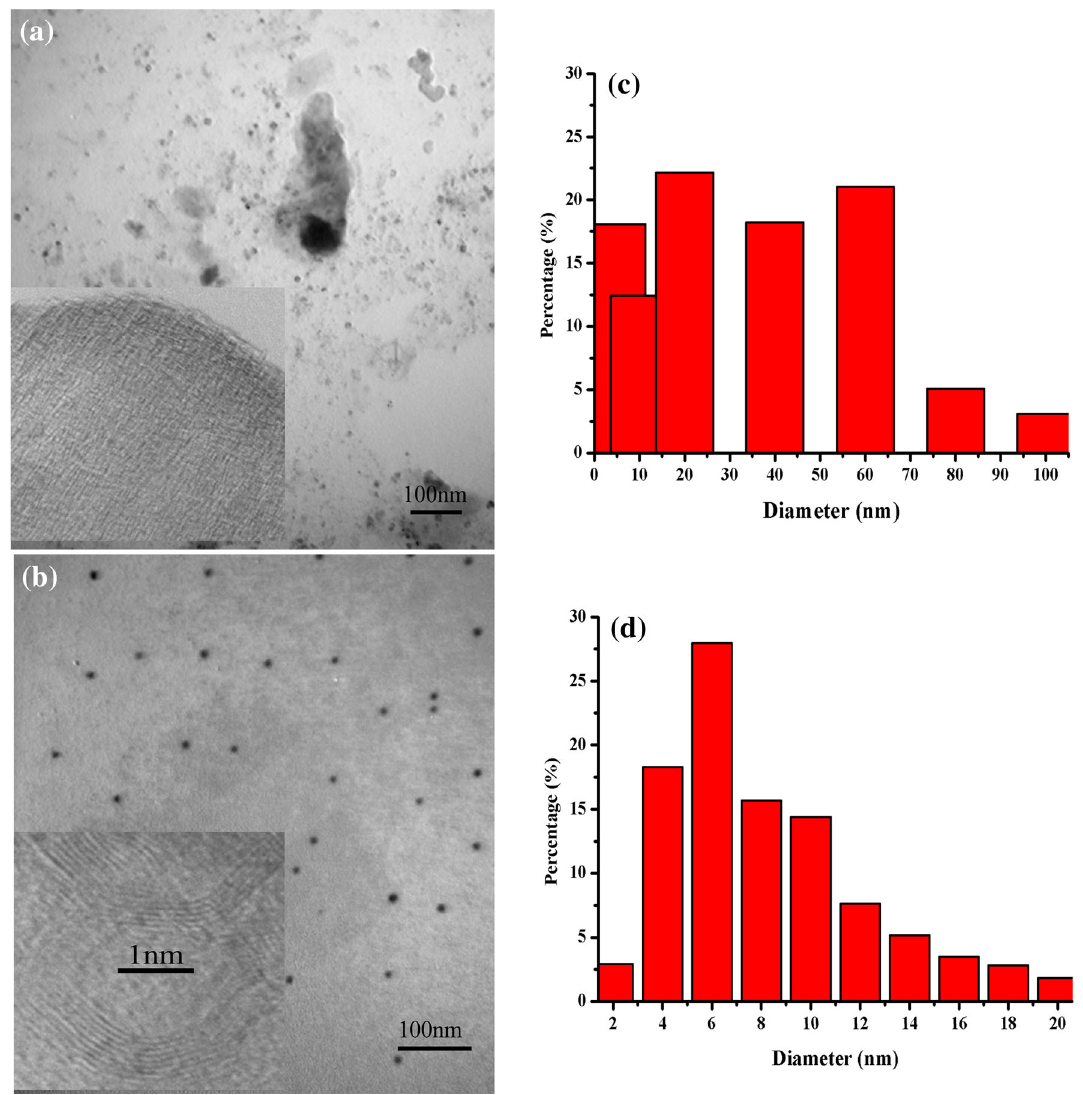
Fig. 6 TEM micrographs ( a , b ) and particle size distribution ( c , d ) of depolymerization products of coal at different pH: a , c pH = 0.012 b , d pH = 1.99–4.09, Illustrations for high power